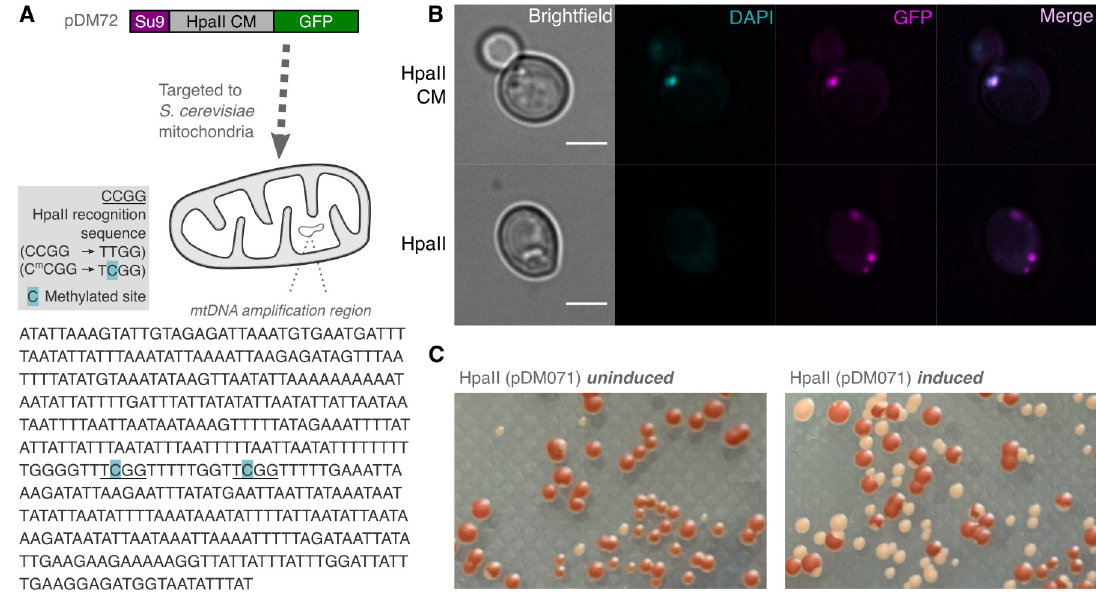
Fig 4. Katablepharid HpaII endonuclease and methyltransferase function in S . cerevisiae mitochondria. (A) Bisulfite conversion and subsequent sequencing to confirm targeting of a functional HpaII-CM to yeast mitochondria. Schematic of bisulfite conversion protocol to assess 5-methylcytosine modifications after induction of the katablepharid HpaII-CM from plasmid pDM072. 5-mC residues were detected within the amplification region of the cox1 gene. Each methylated site (indicated in blue) was located at the HpaII recognition sequence (underlined). (B) Evaluation of fluorescence for GFP-tagged HpaII-CM and HpaII, in conjunction with DAPI- labelled mtDNA. The HpaII-CM showed co-localisation with DAPI, while HpaII showed an absence of a DAPI focus, indicative of a lack of mtDNA, which is likely to have been a result of endonuclease function and DNA degradation. Scale bar = 3 μ m. (C) HpaII expression causes petite formation. Formation of petite colonies (white; due to a lack of an electron transport chain function) after the induction of HpaII (right), in comparison to an uninduced strain (left). CM, cytosine